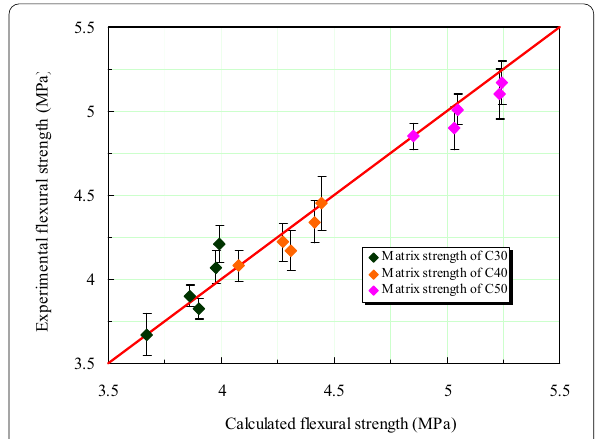
Fig. 14 Predicted and experimental values of flexural strength of